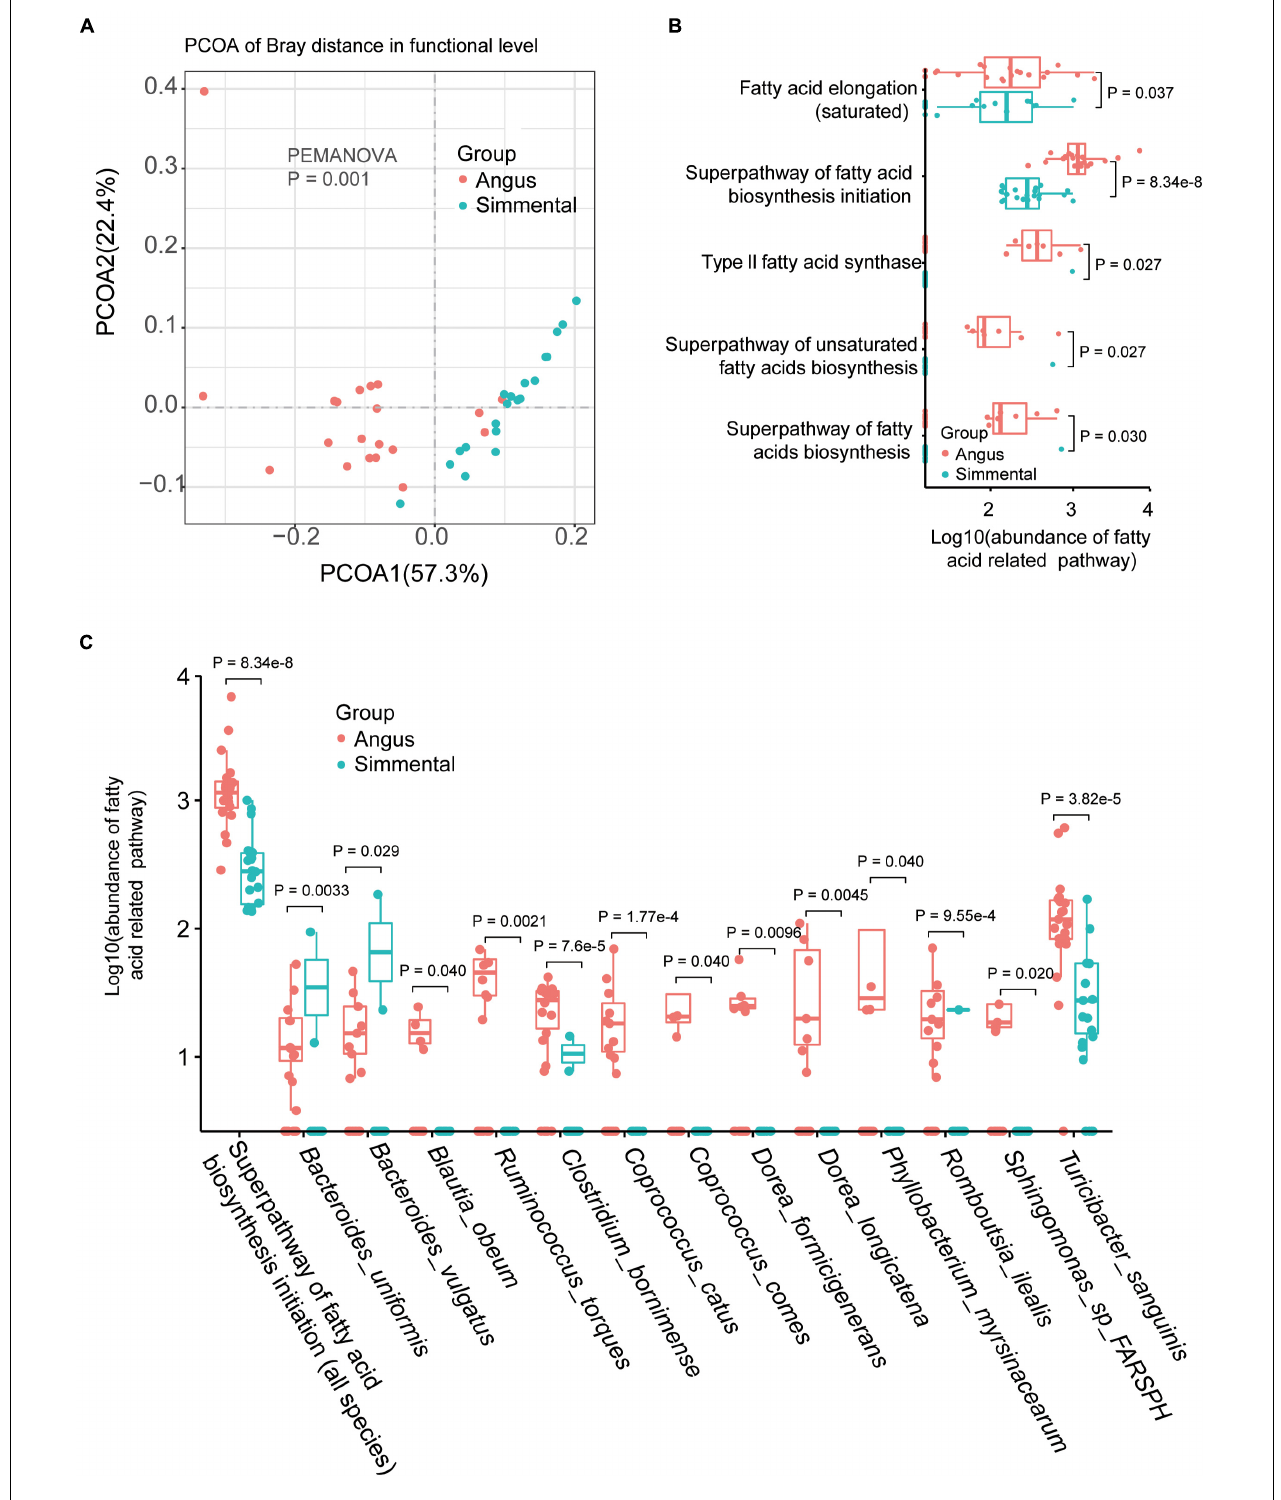
FIGURE 2 | Gut microbial functional differences and the related species. Gut microbial function was significantly different between the two breeds (A) . The abundance of the fatty acid-related pathway was obviously different for the two breeds (B) . Species related to the superpathway of fatty acid biosynthesis initiation were also significantly different between the two breeds (C)